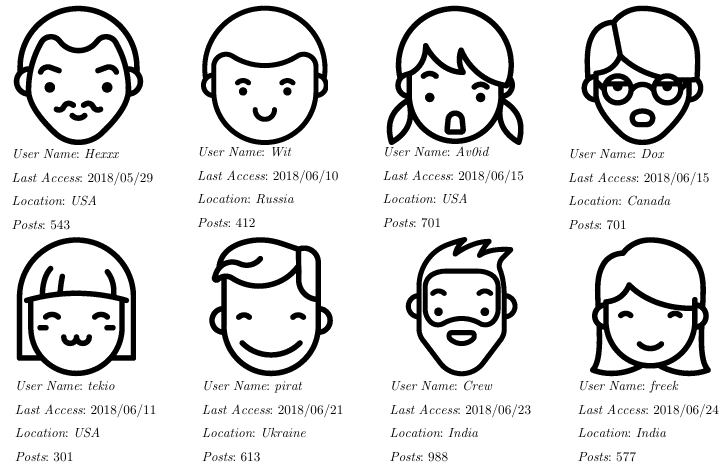
Figure 1. In real-world applications such as Dark Web forums and marketplaces, it may not always be clear who is behind user profiles. In particular, there may be two or more profiles that correspond to the same